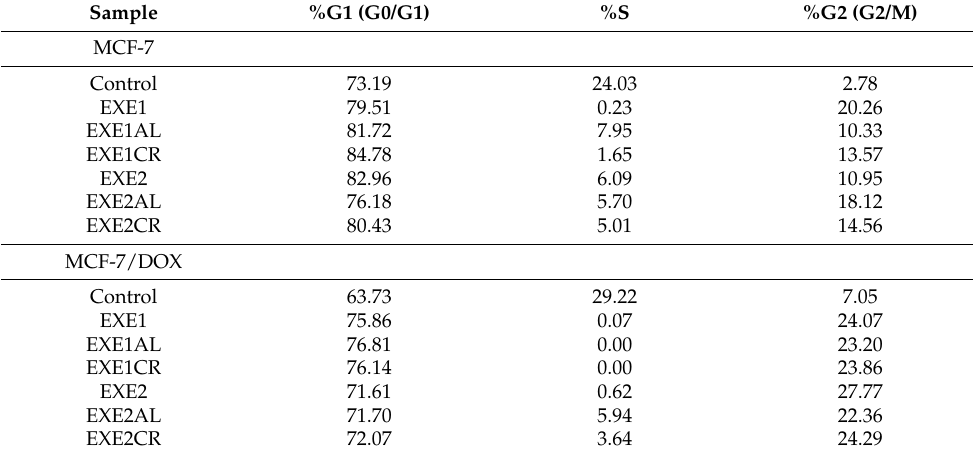
Table 1. Effect of exemestane and its combination with metalloestrogens on cell cycle in MCF-7 and MCF-7/DOX cell lines. EXE1 = 100 µ M; EXE2 = 200 µ M; and Al/Cr(III) = 100 µ M. The results are presented as mean, n = 3.